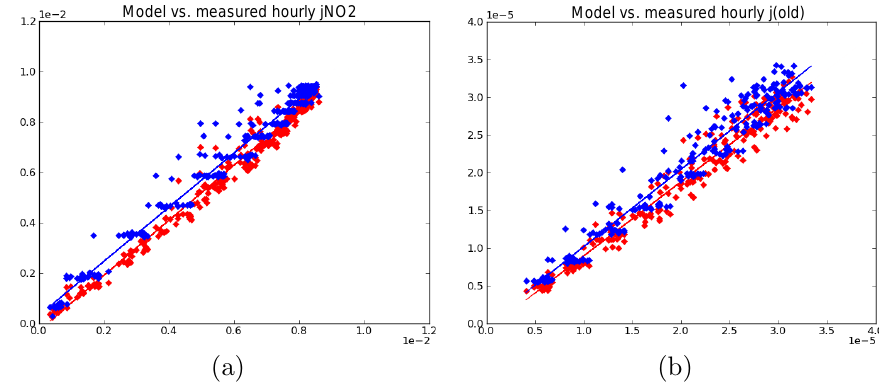
Figure 15. (a) Scatter plot of hourly modelled J( NO 2 ) vs. measured J( NO 2 ) at Lampedusa for 698 points with valid daytime measurements of J( NO 2 ) . Red diamonds represent the J( NO 2 ) values in the REF simulation, blue diamonds the J( NO 2 ) values in the NA simulation, with the respective regression lines; (b) same as (a) for J( O 1 D ) , with 610 valid data